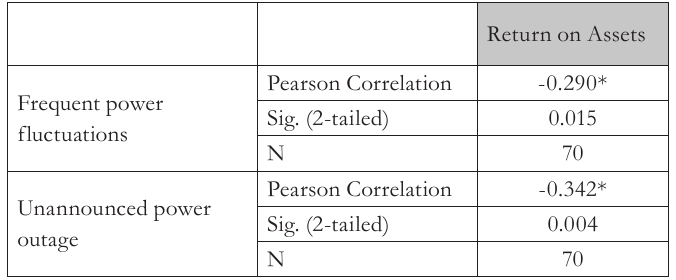
Tab. 4 - Relationship between power fluctuation and profitability (Return on Assets - ROA). Source: Survey data,